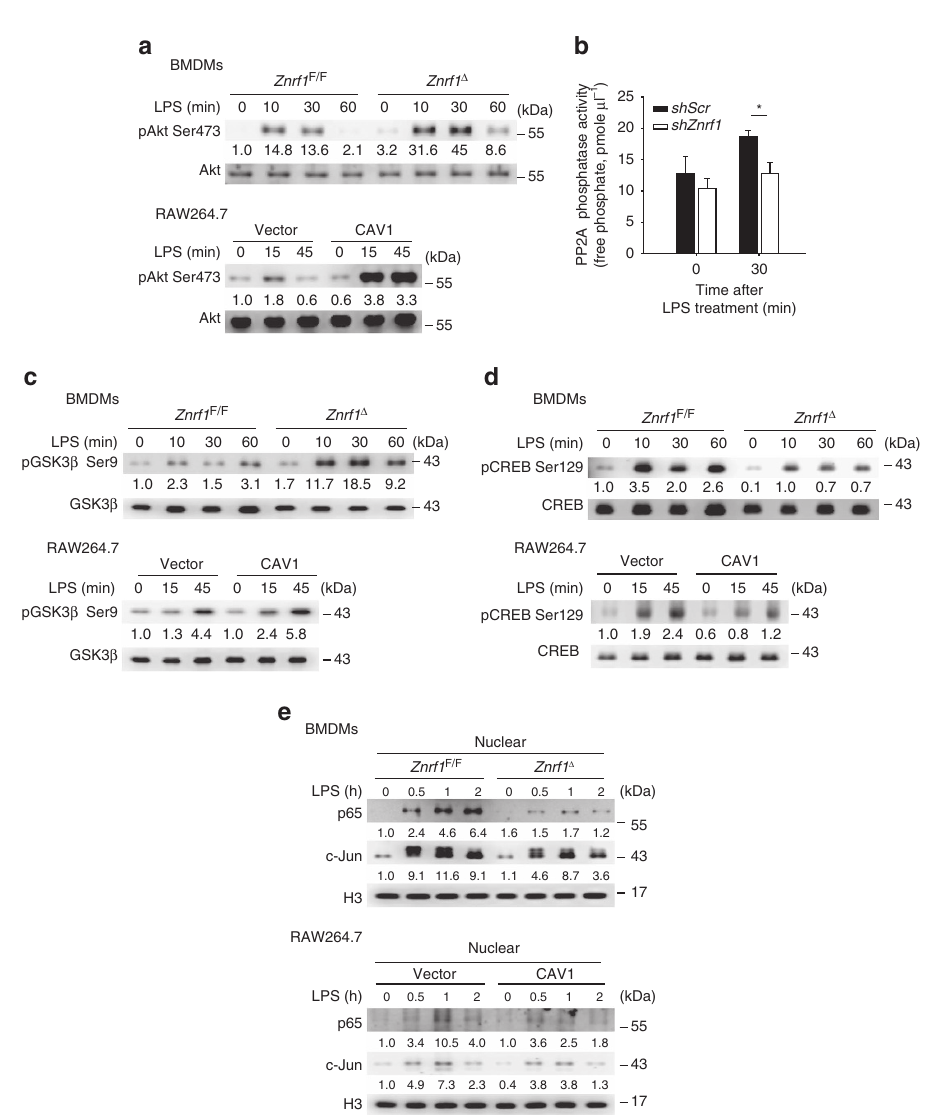
monitored the PP2A activity in both shZnrf1 and shScr cells. PP2A phosphatase activity was indeed impaired in ZNRF1 depletion cells upon TLR4 engagement (Fig. 6b). In addition, phosphorylation of GSK3 b at serine 9 (inactive form of GSK3 b ) was elevated in both Znrf1 D BMDMs and CAV1-overexpressing RAW264.7 cells, indicating that increasing CAV1 expression suppresses GSK3 b activity by enhancing Akt activation in TLR4- activated macrophages (Fig. 6c). GSK3 b phosphorylates the transcription factor CREB at serine 129, resulting in a loss of the DNA-binding activity of CREB 29,30 . CREB was shown to be a critical positive regulator of IL-10 transcription, and inhibiting GSK3 b activation enhanced CREB activity and, consequently, increased IL-10 mRNA expression 31 . Thus, we assessed whether